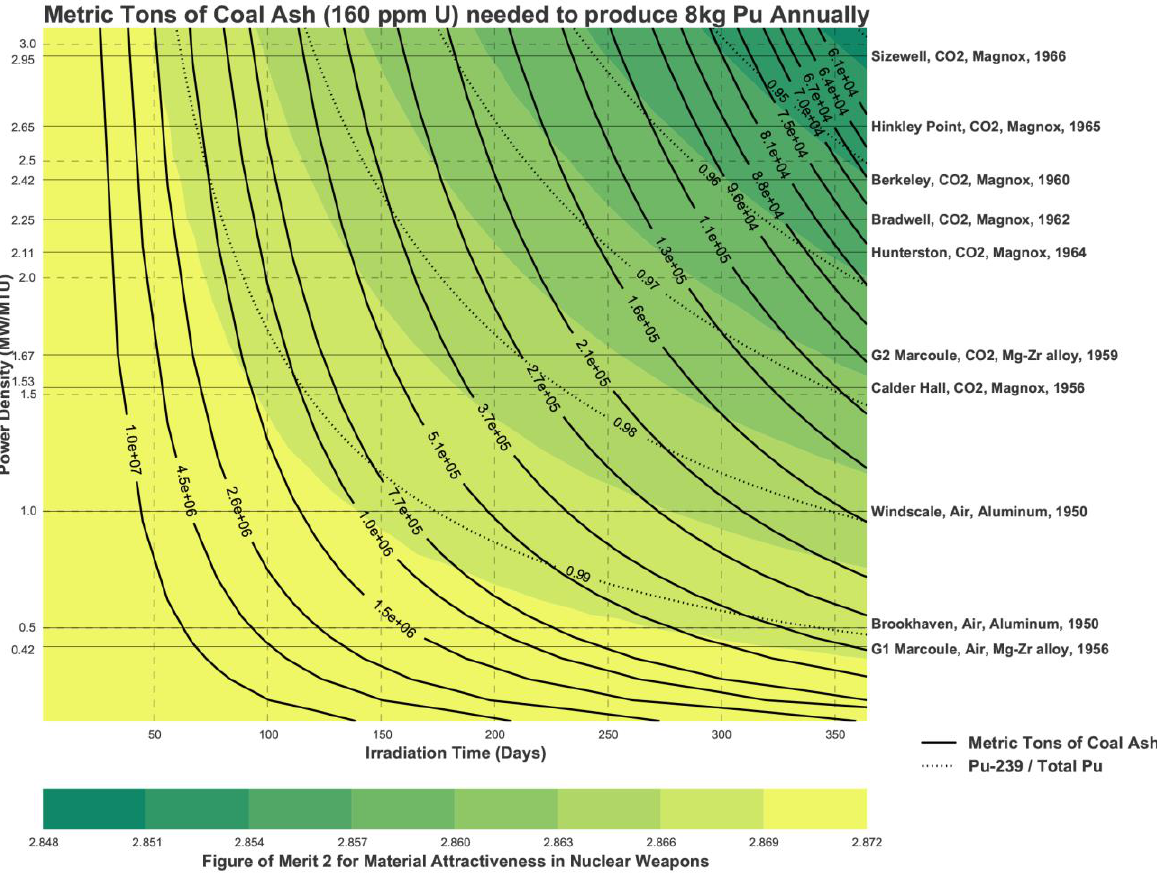
Figure 4. Grid of power density and irradiation time combinations comparing the amount of uranium bearing coal ash required to produce one BSCM, FOM 2 evaluations, 239 Pu to total PU mass ratio. Historical reactor examples are show as well, with their name, cooling gas, cladding material, and year of initial